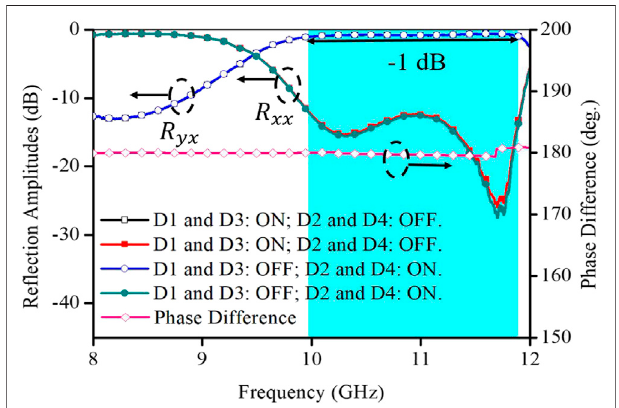
FIGURE 2 | Simulation results for the proposed metasurface at normal incidence.